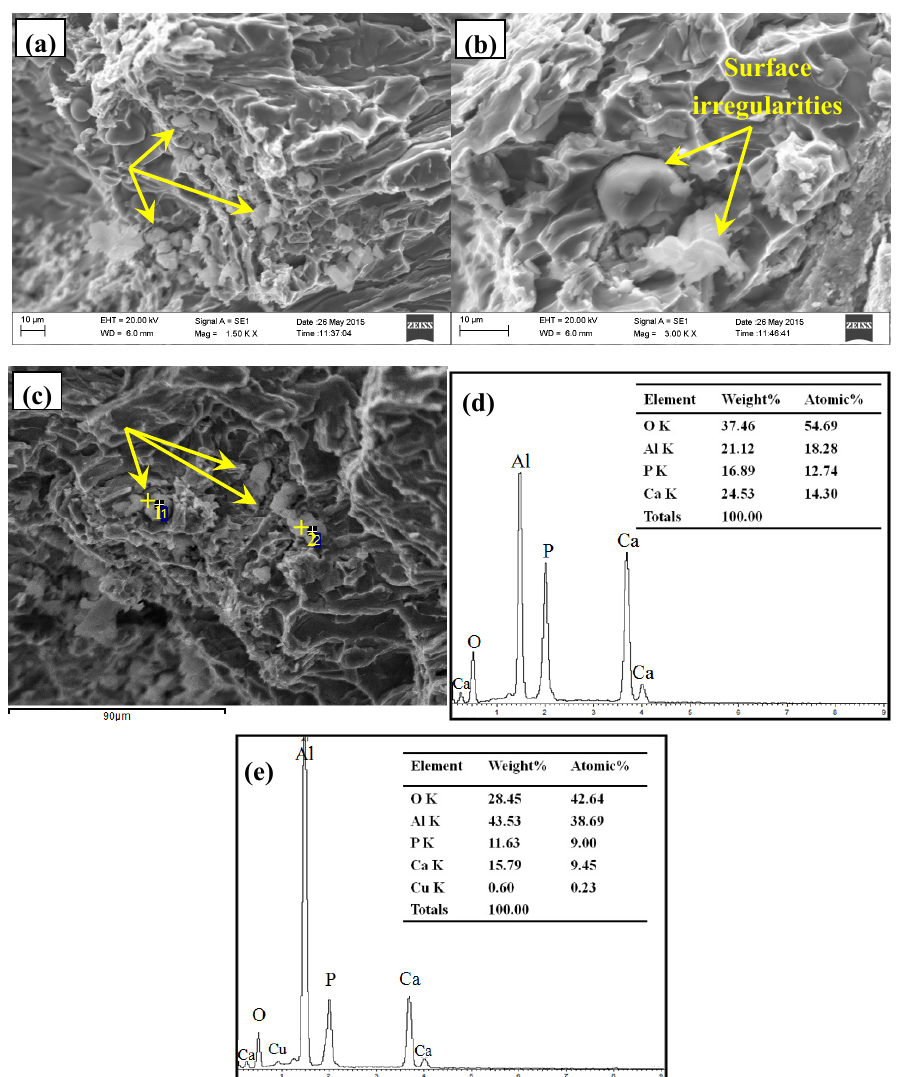
Figure 5. Field emission scanning electron microscope(FESEM) micrographs and energy dispersive X-ray spectrometer(EDS) analysis of Ca-rich compounds in Al–2Ca–3Y–1P alloys: ( a – c ) typical microstructures; ( d , e ) the corresponding EDS analysis for the spots 1 and 2 in ( c ), respectively. Materials 2017 , 10 , 1356